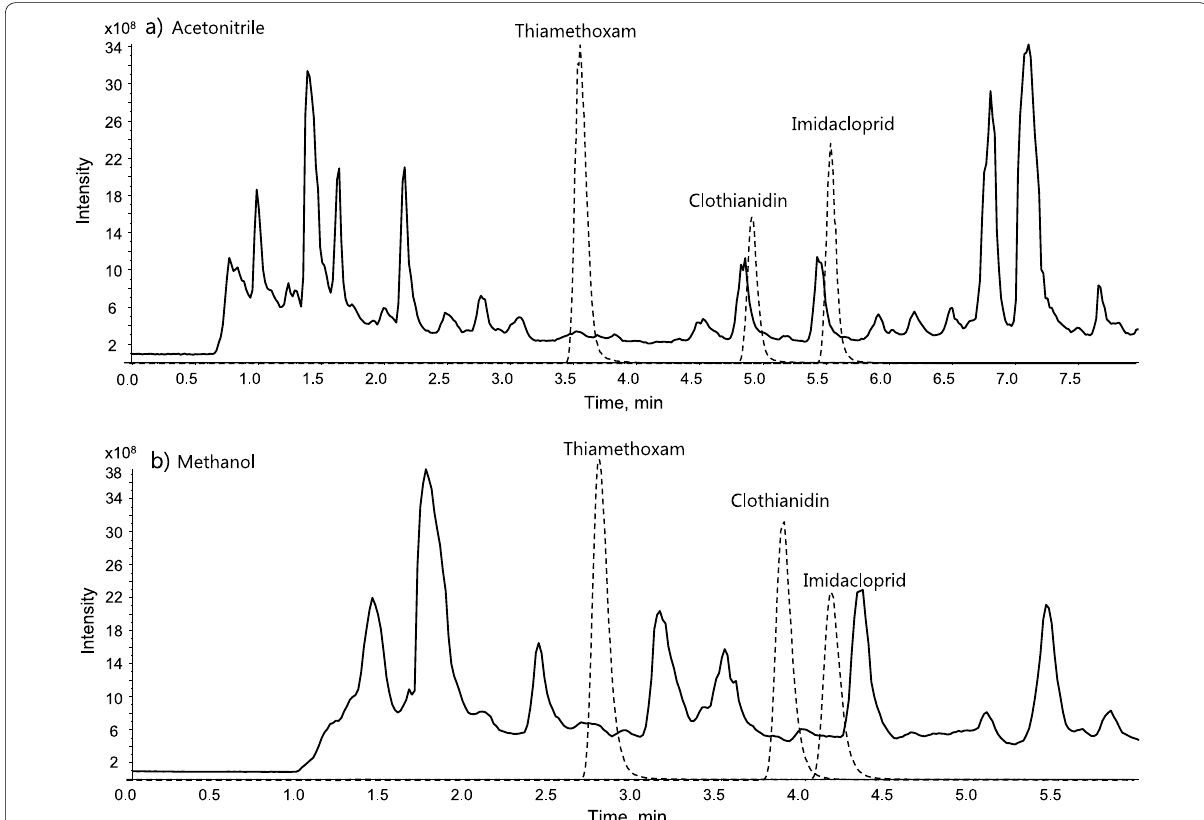
Fig. 2 Chromatograms of scan mode (solid line) for the eluent from kimchi cabbage (blank kimchi cabbage) and SRM mode (dashed line) of standard solution mixture of imidacloprid, clothianidin, and thiametoxam with a acetonitrile and b methanol as an organic mobile phase of